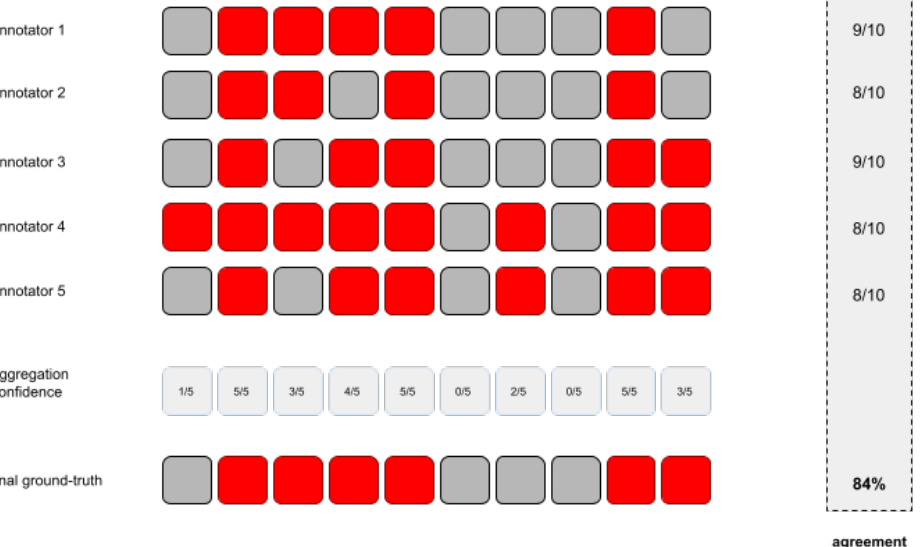
Figure 5. Example of aggregating annotation decisions from five different human annotators. The final dataset (both raw data and respective annotations) (https://drive.google.